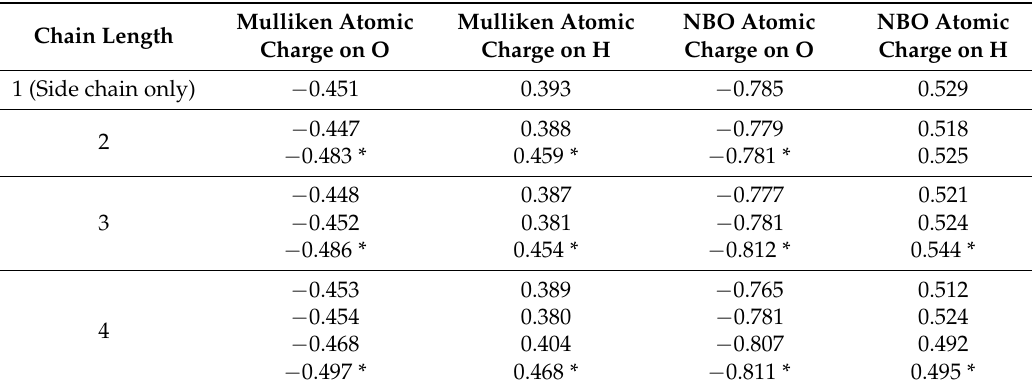
Figure 4. Mulliken atomic charges on the SXFA unit and benzene atoms. Table 1. Mulliken and NBO Atomic Charges on OH ‐ group.